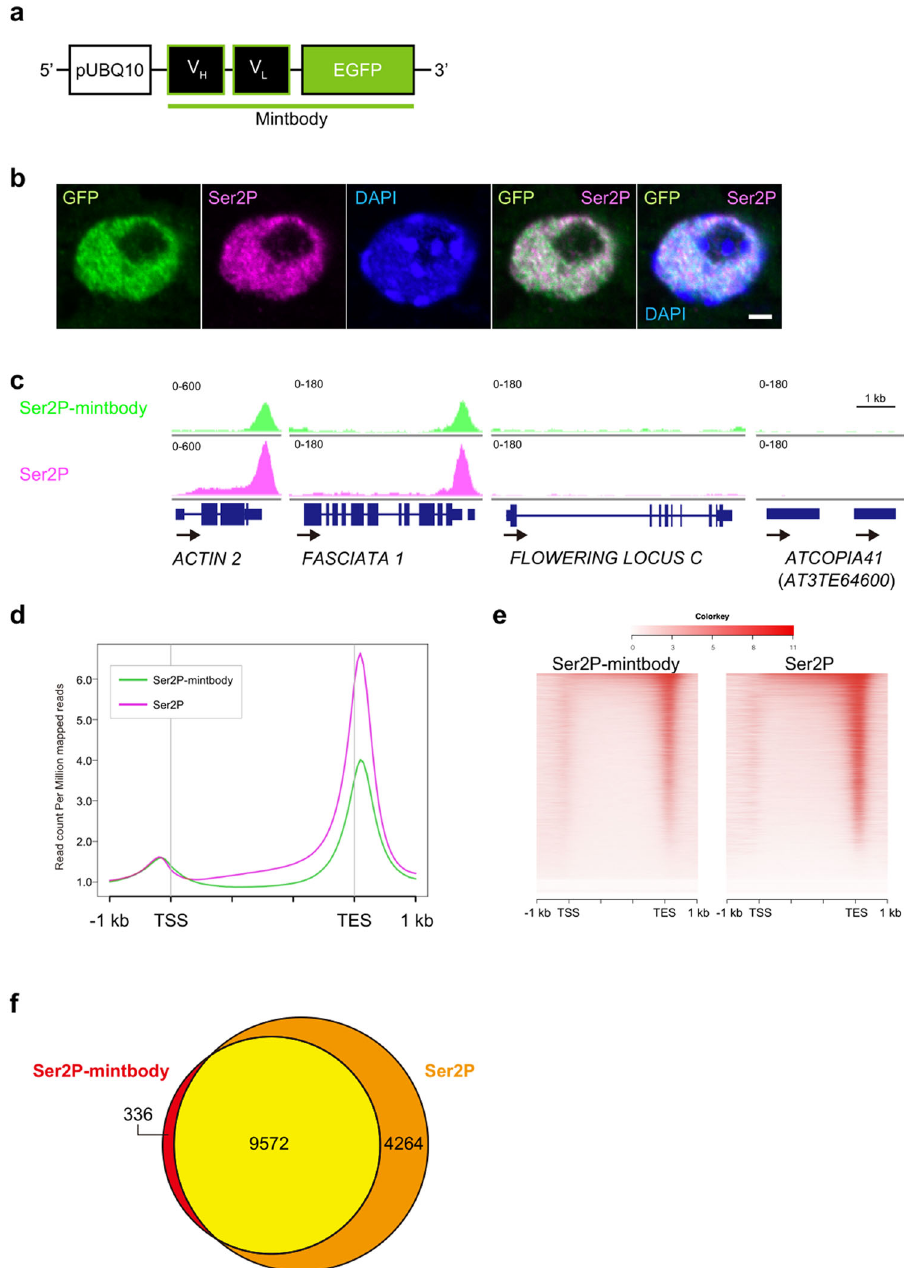
Fig. 1 Capacity of Ser2P-mintbody to bind with Ser2P in living Arabidopsis seedlings. a Schematic diagram of the expression cassette of Ser2P-mintbody. pUBQ10: UBIQUITIN10 (AT4G05320) promoter; V H : heavy chain variable domain of anti-Ser2P antibody; V L : light chain variable domain of anti-Ser2P antibody. b Immunostained images of Ser2P-mintbody and Ser2P. Nuclei in root expressing pUBQ10:Ser2P-mintbody were fi xed, immunostained with anti- GFP (green) and anti-Ser2P (magenta) antibodies, and stained with DAPI (blue). Scale bar: 2 µ m. c Genome-browser view of ChIP-seq peaks at representative loci: active genes, ACTIN 2 (AT3G18780) and FASCIATA 1 (AT1G65470); a repressed gene, FLOWERING LOCUS C (AT5G10140); a transposon, ATCOPIA41 (AT3TE64600). d , e Distribution of Ser2P-mintbody and Ser2P vs. gene-body shown as an average pro fi le plot ( d ) and as heatmaps ( e ). TSS transcription start site, TES transcription end site, − 1 kb: 1 kb upstream of TSS; 1 kb: 1 kb downstream of TES. f Venn diagram showing the overlap of Ser2P-mintbody- and Ser2P-enriched